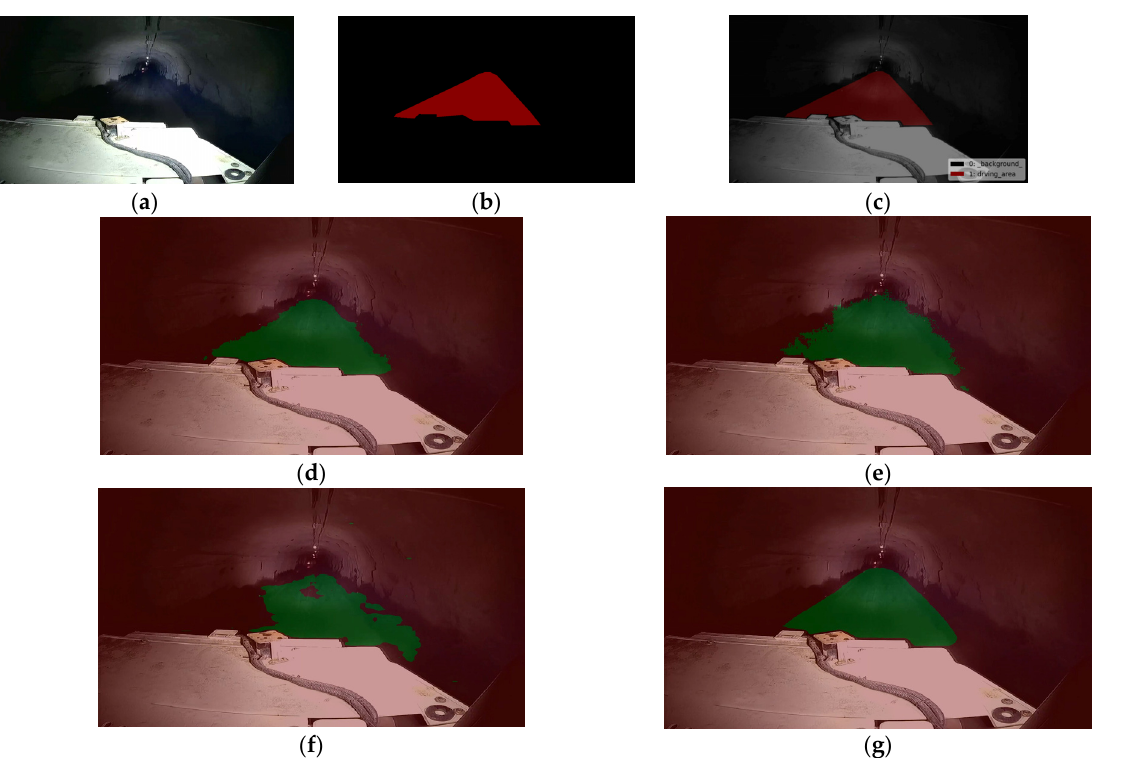
Figure 13. Results comparison chart: ( a ) original image; ( b ) label; ( c ) target; ( d ) SegNet; ( e ) ENet; ( f ) BiSeNet; and ( g ) the network in this article.